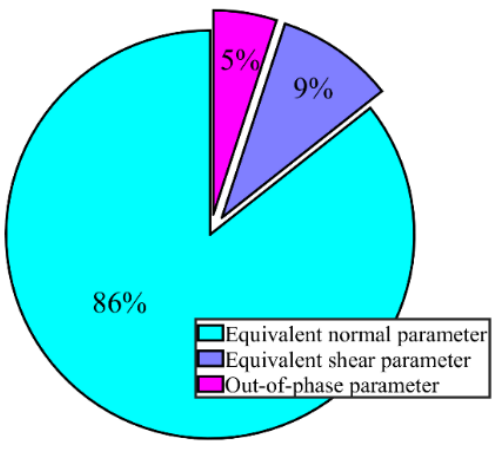
Figure 11. The contribution of different parameters on multiaxial thermomechanical fatigue of the brake disc.